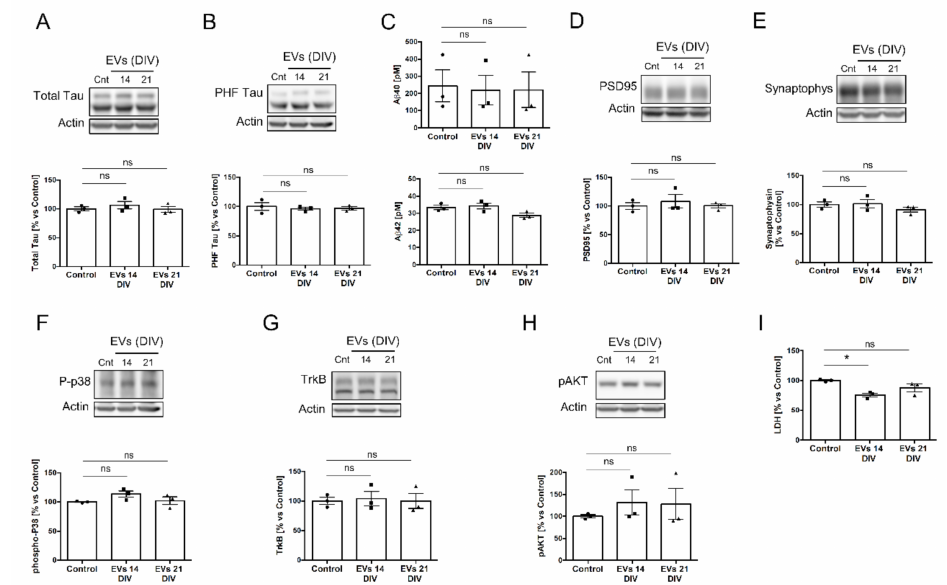
Figure 3. Biological effect of 14 and 21 DIV isolated EVs on 14 DIV rat cortical neural culture for a 24 h treatment period. ( A ) Western blot analysis of total tau protein in 14 DIV neural culture lysates untreated (cnt) or treated for 24 h with EVs isolated from the media of 14 DIV or 21 DIV neural cultures. Actin was used as loading control. The plot shows the levels for total tau protein normalized by actin and quantified from Western blot experiments as the ones shown in this panel. Graph shows the mean protein levels relative to the untreated (control) condition ± SEM ( B ) Same analysis as in panel A, but for tau phosphorylated at S396/T404 (PHF-1 epitope). ( C ) Plots comparing the A β 40 levels (upper graph) or the A β 42 levels (lower graph) in the media of rat cortical neural cultures untreated (control) or treated for 24 h with EVs isolated from the media of 14 DIV or 21 DIV neural cultures. Graph shows the A β concentration (pM) ± SEM. ( D ) Same analysis as in panel A was performed for the postsynaptic protein PSD95, ( E ) the presynaptic protein synaptophysin, ( F ) the phosphorylated form of p38, ( G ) the receptor for neurotrophins TrkB, and ( H ) the phosphorylated form of AKT at S473. ( I ) The plot compares the relative levels of lactate dehydrogenase (LDH) measured in the media of 14 DIV neural cultures untreated (control) or treated for 24 h with EVs isolated from the media of 14 DIV or 21 DIV neural cultures. All graphs show the mean LDH levels relative to the control condition ± SEM. Statistical significance was analyzed by one-way ANOVA. Post hoc analysis was analyzed by Tukey’s Multiple Comparison Test (* p < 0.05; ns =